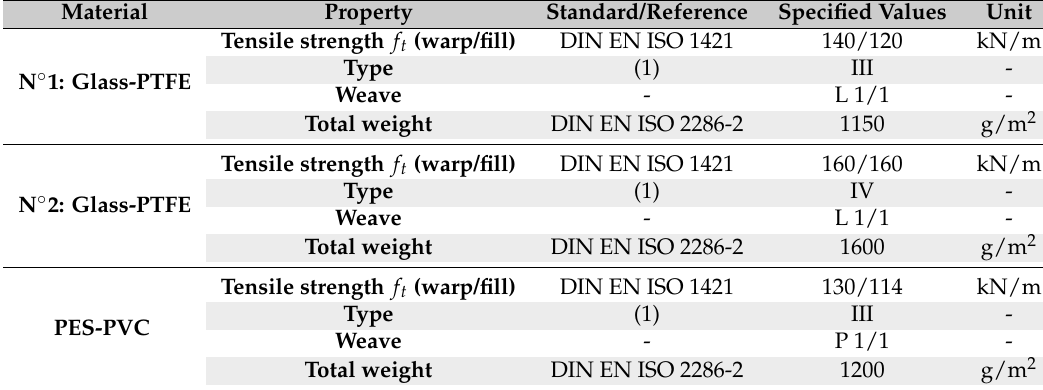
Table 1. Basic properties of the investigated